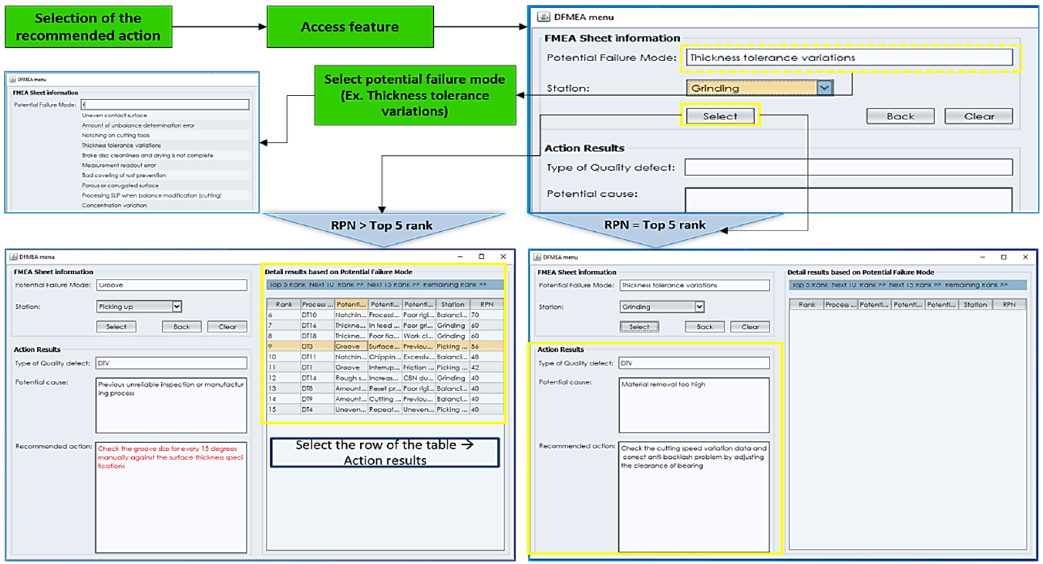
Figure 8. Systematic procedure for accessing DFEMA module.